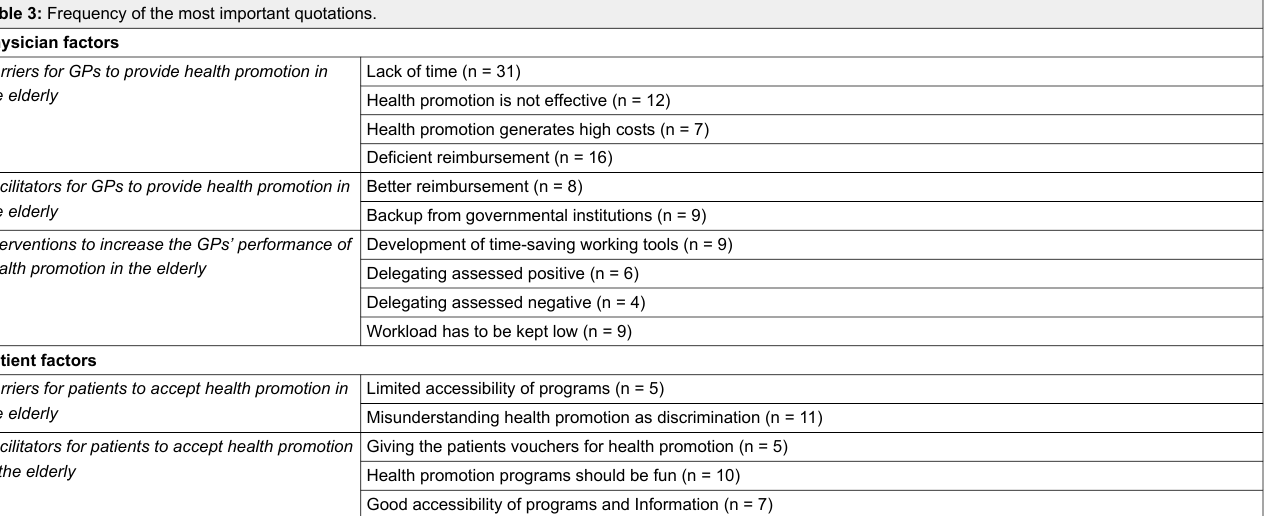
Table 3: Frequency of the most important quotations. Physician factors Barriers for GPs to provide health promotion in the elderly